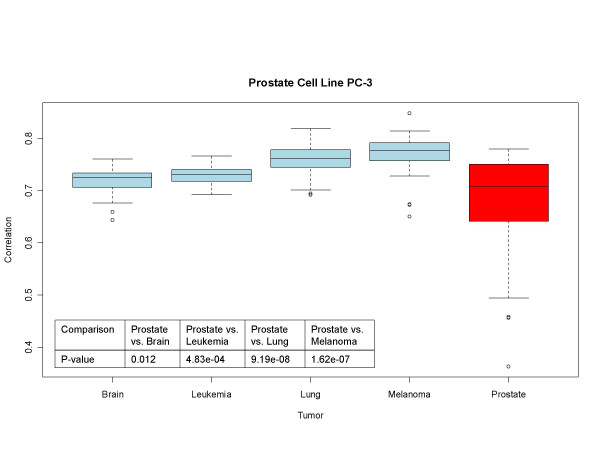
Prostate cell line PC-3 does not represent its corresponding tumor type, as suggested by correlations of gene expression profiles between the cell line and primary tumors. The y-axis represents Pearson's correlation coefficients of gene expression profiles between the cell line and primary tumors. Labeled on x-axis are tumor types. Presumed tumor origin for the cell line is red-colored. The p-values of ANOVA tests for mean correlation coefficients are indicated in the table.